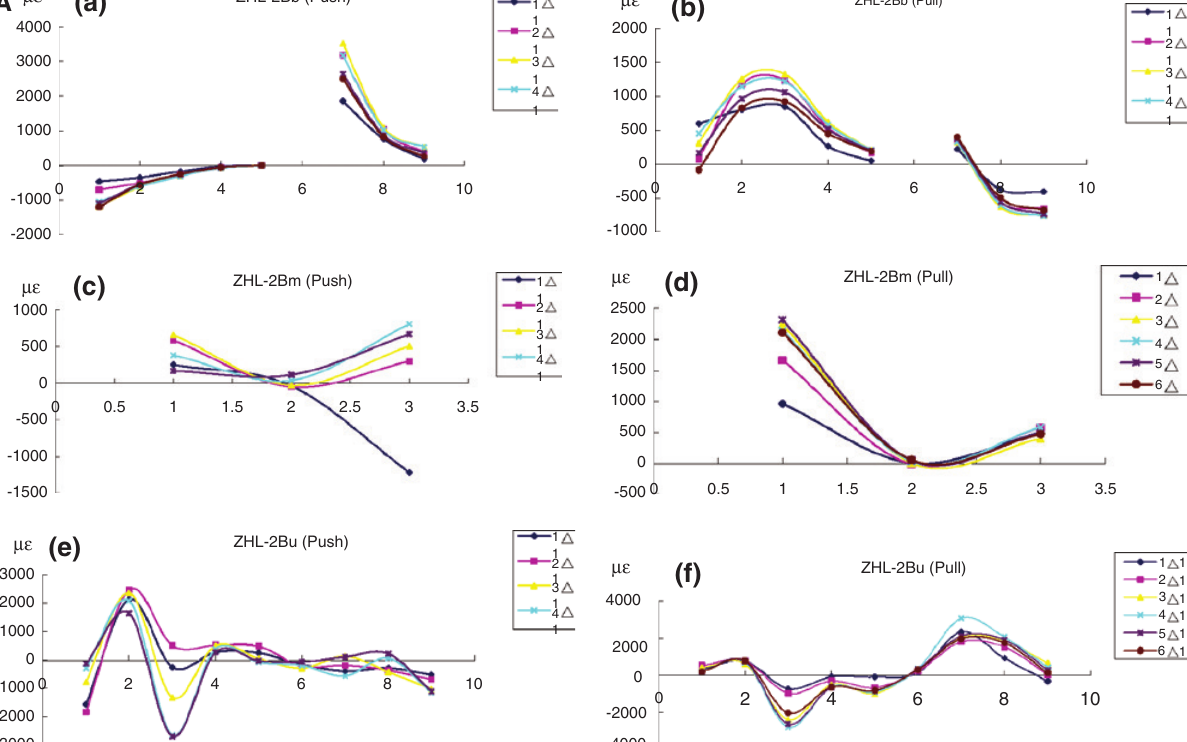
Figure 6: Strain curves for bars of a test piece. (A) strain curves for bars of ZHL-2; (a) strain curves for lower bars pushed; (b) strain curves for lower bars pulled; (c) strain curves for middle bars pushed; (d) strain curves for middle bars pulled; (e) strain curves for upper bars pushed; (f) strain curves for upper bars pulled; (B) strain curves for bars of ZHL-3; (a) strain curves for lower bars pushed; (b) strain curves for lower bars pulled; (c) strain curves for middle bars pushed; (d) strain curves for middle bars pulled; (e) strain curves for upper bars pushed; (f) strain curves for upper bars pulled; (C) strain curves for bars of ZHL-4; (a) strain curves for lower bars pushed; (b) strain curves for lower bars pulled; (c) strain curves for middle bars pushed; (d) strain curves for middle bars pulled; (e) strain curves for upper bars pushed; (f) strain curves for upper bars